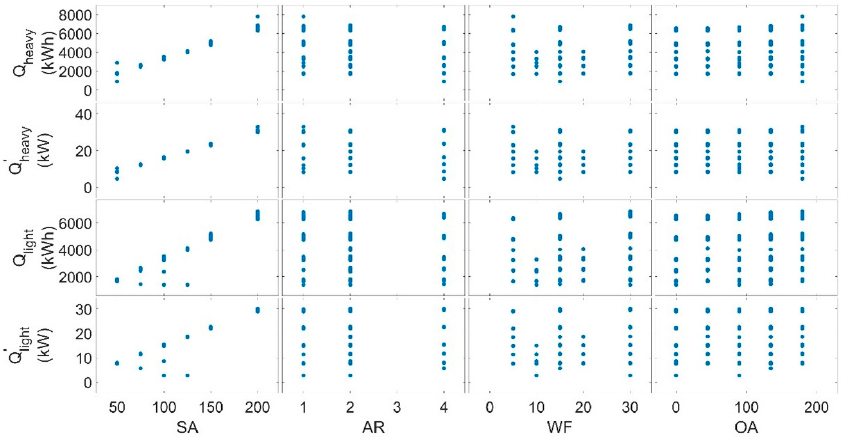
Figure 5. Total heat demand and maximum power for heavy- and light-structured buildings for the first 1000 h of a TMY with respect to various geometric features (results from TRNSYS).